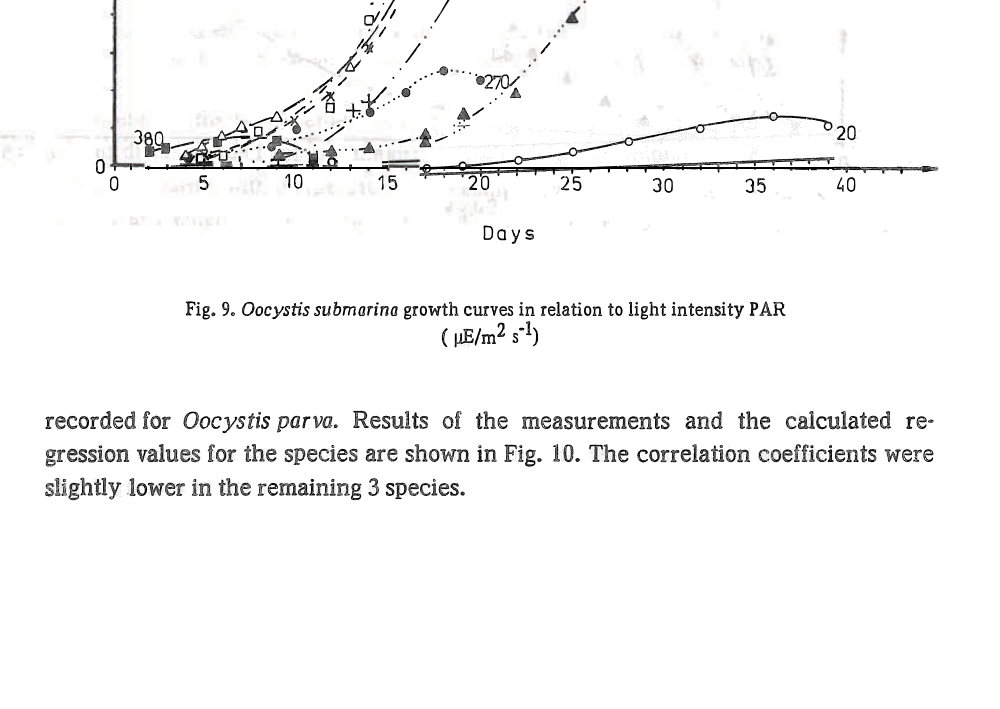
Fig. 9. Oocystis submarina growth curves in relation to light intensity PAR